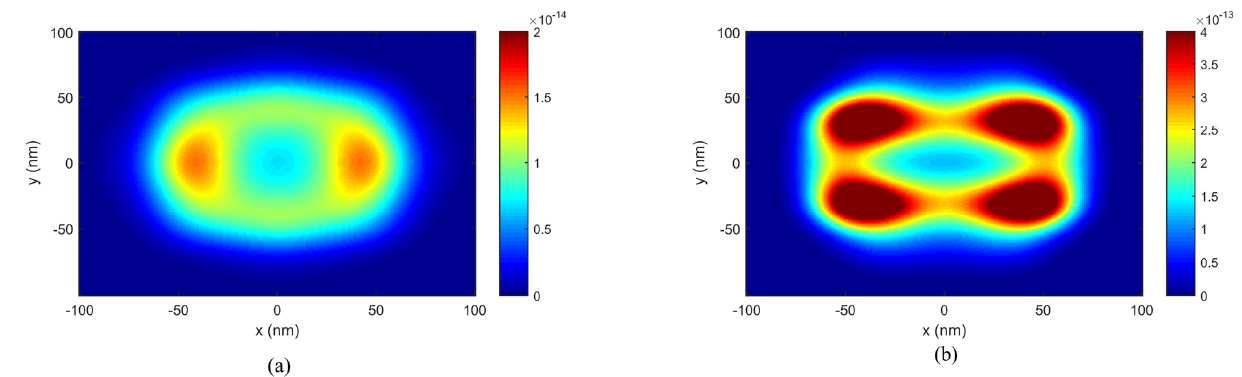
Figure 4 . Far-field radiation patterns at ( a ) planar DUV-LEDs and ( b ) nanopillar structure with height of 170 nm and width of 20 nm.